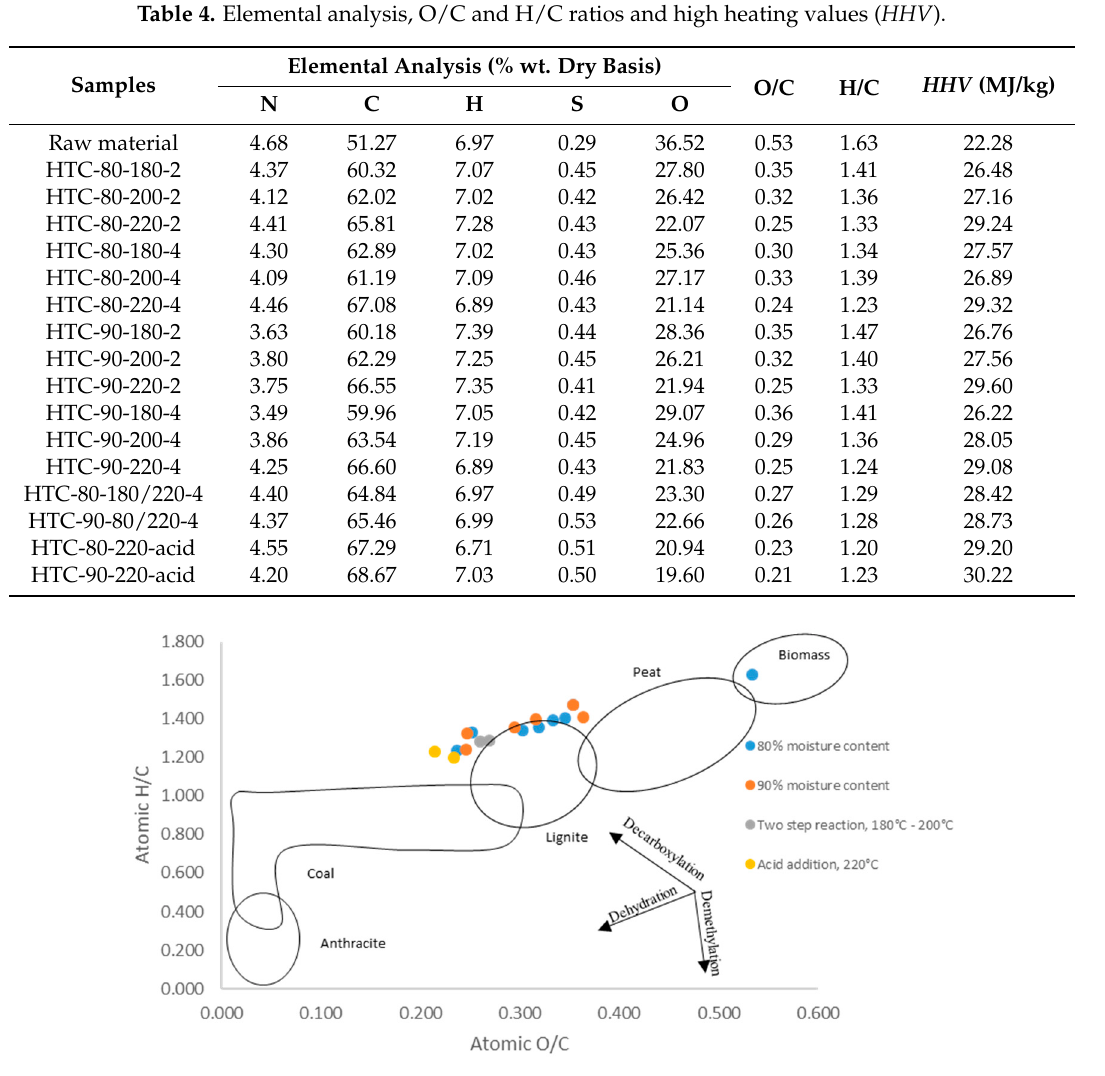
O/C H/C HHV (MJ/kg)